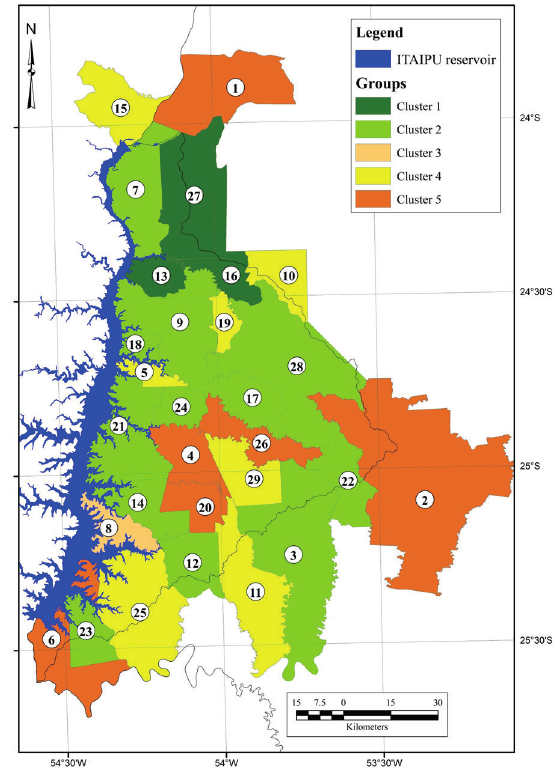
Figure 3 - Clusters of the municipalities of Paraná Watershed III (PB3) as a function of soil and water conservation